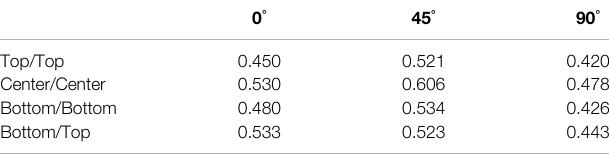
TABLE 2 | Summary of ventilation ef fi